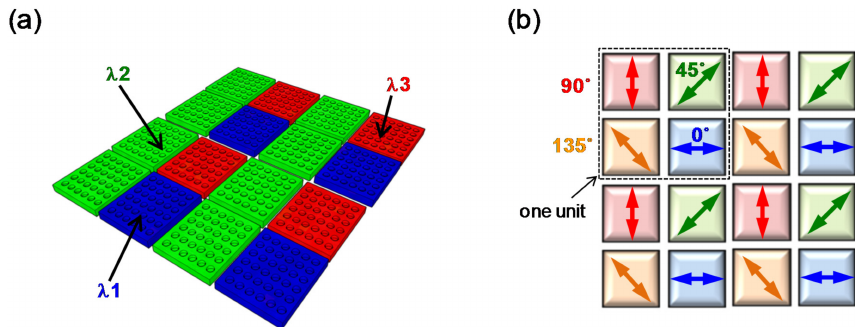
Figure 3. Concept of pixel integration in an array format for ( a ) multi-color; and ( b ) polarimetric imaging using